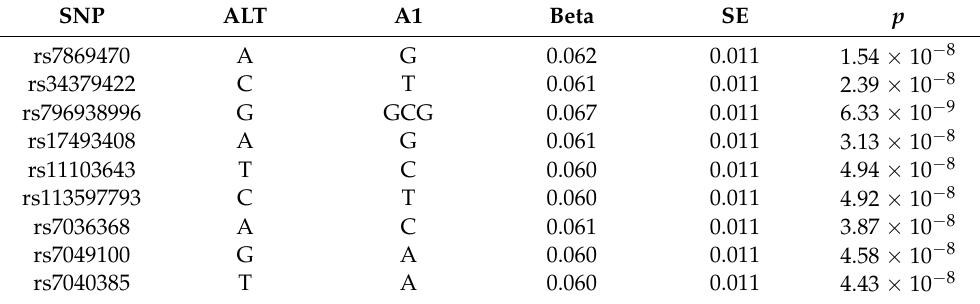
Figure 1. Genome-wide environmental interaction study in champagne/white wine glasses per month of depression. ( A ) Manhattan plot. The black solid line indicates the p value threshold for genome-wide significance ( p < 5 × 10 − 8 ) while the black dotted line indicates p value threshold for suggestive significance ( p < 5 × 10 − 5 ). ( B ) QQ plot. A graphical representation of the deviation of the observed p values from the null hypothesis: the observed p values for each single nucleotide polymorphism (SNP) are sorted from largest to smallest and plotted against expected values from a theoretical χ 2 -distribution. ( C ) Locus Zoom plot for gene OLFM1 . Association results for SNPs as a function of genomic distance for OLFM1 . The display range is chr9: 137767088 − 138213030. Purple diamond indicates SNP at the locus with the strongest association evidence (rs7869470). Each point represents an SNP. Table 2. The significant SNPs interacted with champagne/white wine glasses per month for